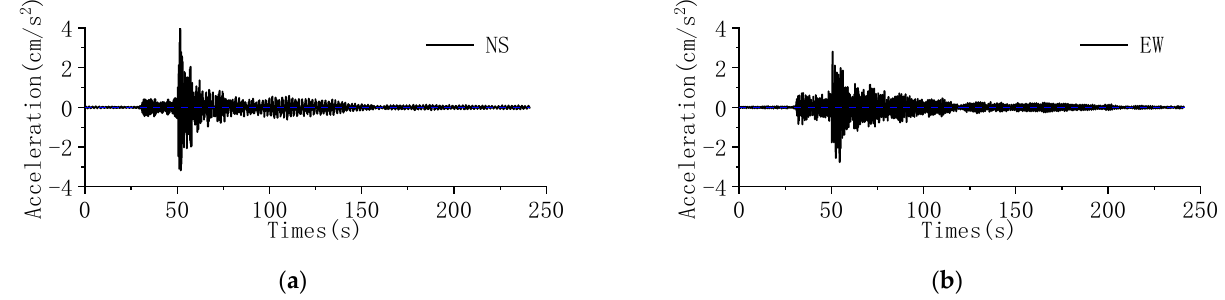
Figure 11. Acceleration time history curves of the structural response records during Songyuan earthquake ( a ) NS; ( b ) EW.